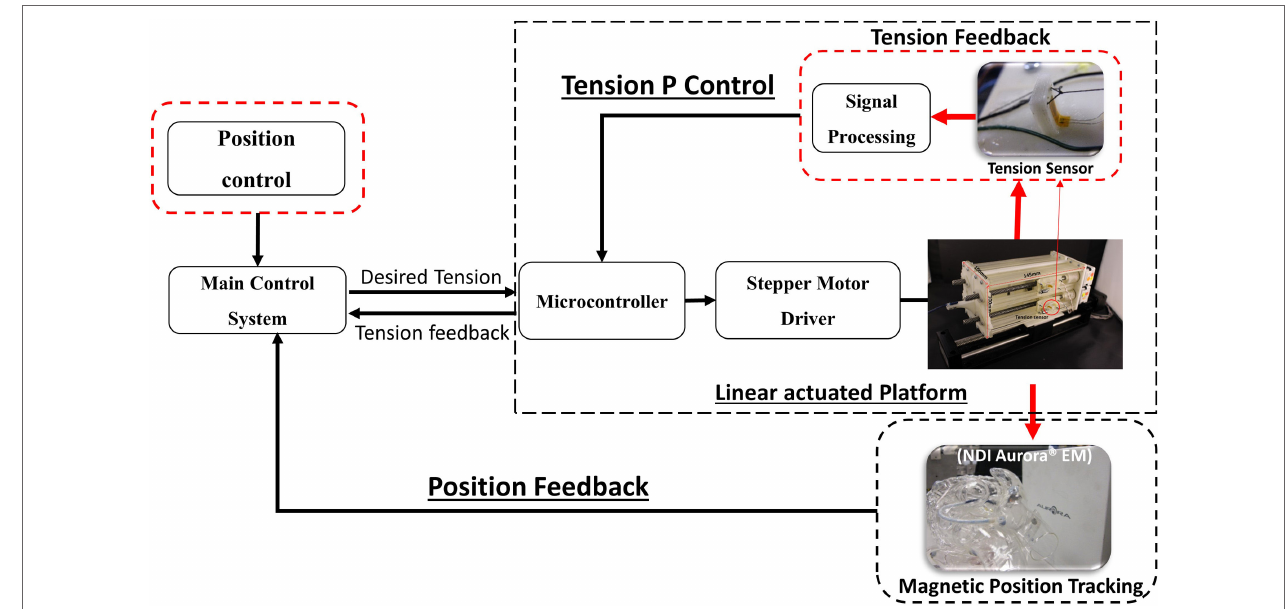
FigUre 2 | schematic diagram showing the configuration of the linear actuated catheter robot